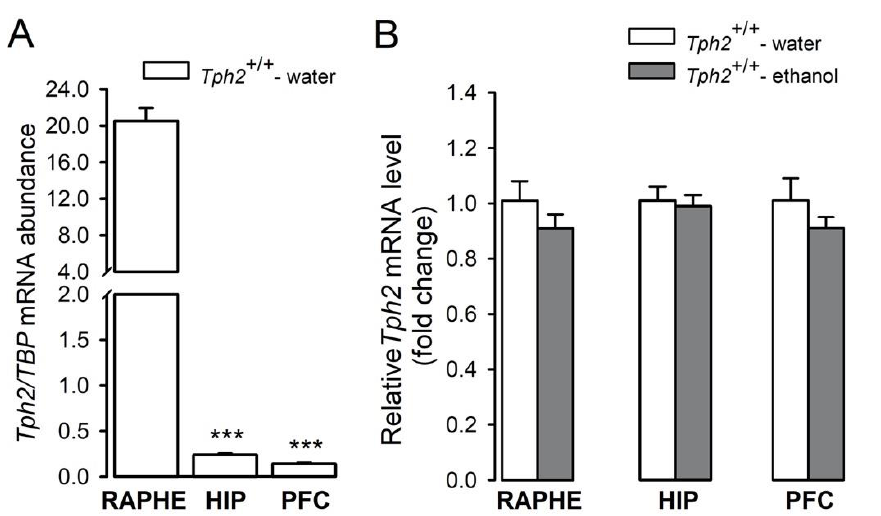
Figure 3. Effects of chronic ethanol consumption on the transcript levels of Tph2 in the selected mouse brain structures. Tph2 +/+ mice were exposed to increasing concentrations of ethanol (3–10%) for 29 days. Animals that were given access to two bottles of water were used as controls. On the last day of ethanol drinking, mice were introduced to the FST and, after the test, they were immediately killed by decapitation. The Tph2 transcript level was analyzed in the raphe nuclei (RAPHE), hippocampus (HIP), and prefrontal cortex (PFC) by RT-qPCR. All the data were normalized to a housekeeping gene, TATA box binding protein ( Tbp ). To show differential expression of Tph2 in the brain of control mice, the abundance of Tph2 mRNA was calculated ( A ). In the analysis of the effects of ethanol on Tph2 transcript level ( B ), results were shown as fold change (2 − ∆∆ C T ) to control mice. Data are presented as means of data from 5–17 mice/group. ( A ): post hoc Newman–Keuls: *** p < 0.001 vs. Tph2 +/+ -water (RAPHE).